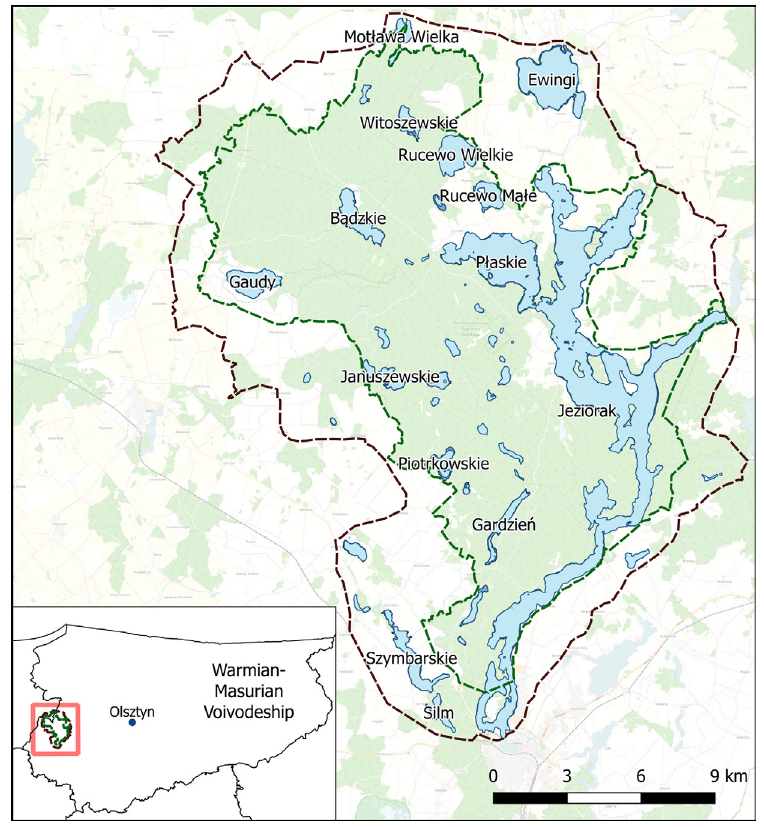
Fig. 1. Location of lakes in Iława Lakeland Landscape